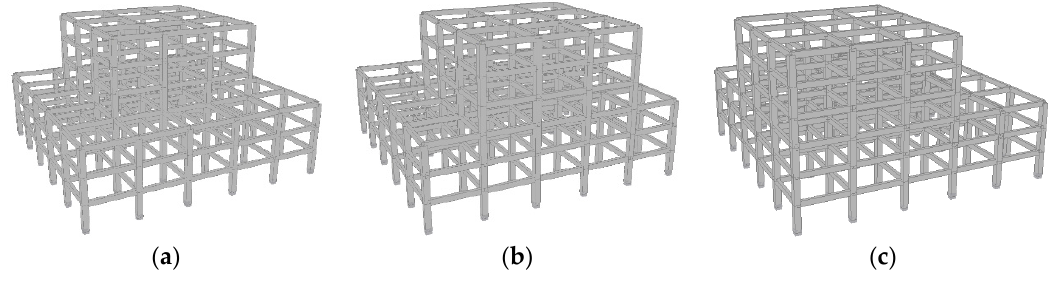
Figure 1. The 3D plots of structures. ( a ) Model A; ( b ) Model B; ( c ) Model C.